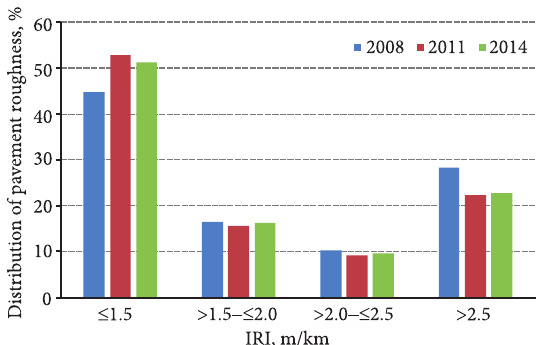
Fig. 3. Distribution of pavement roughness in main roads of Lithuania